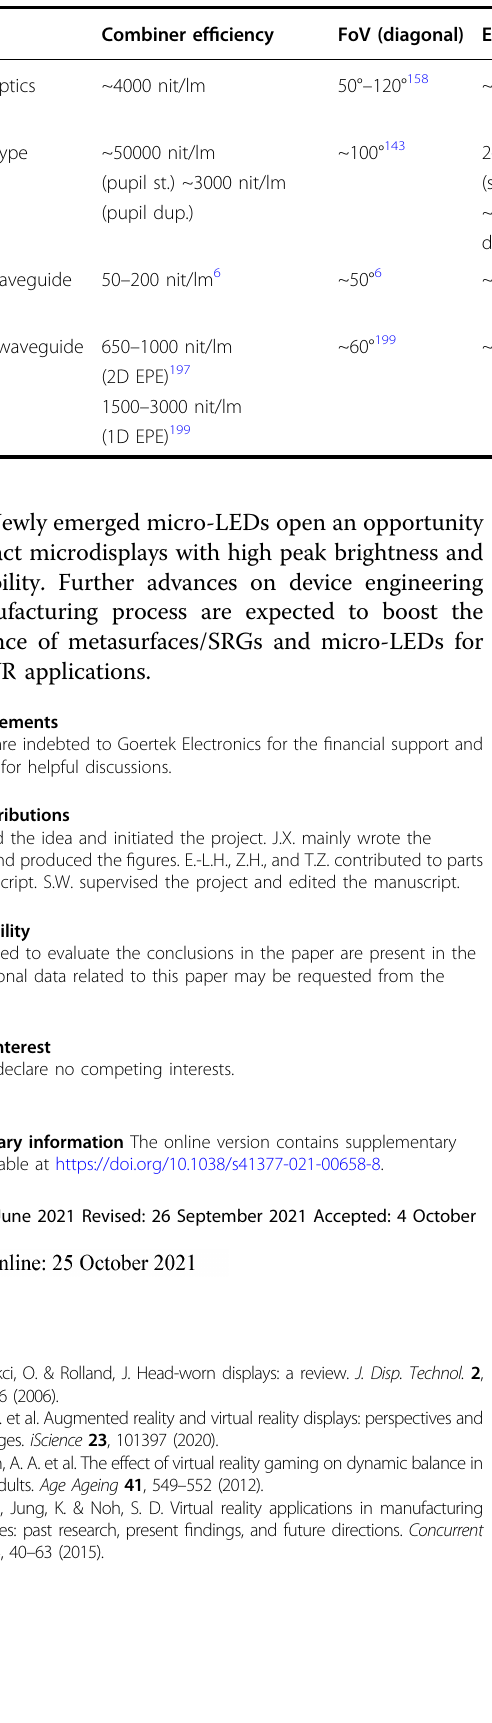
Table 2 Comparison of different AR